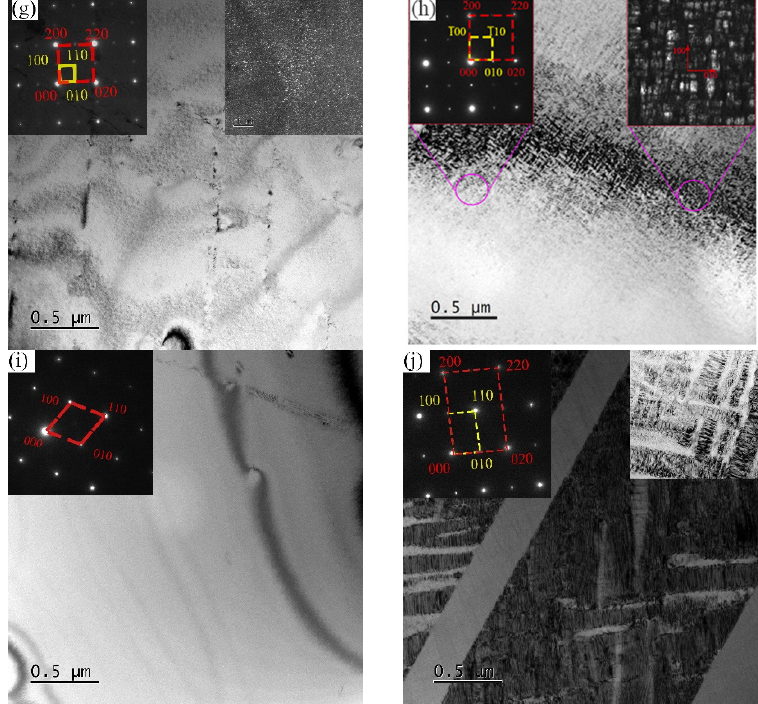
Figure 2. TEM morphology and diffraction patterns of experimental steels: ( a ) 7% Al under water- quenched, ( b ) 7% Al under furnace-cooled, ( c ) 8% Al under water-quenched, ( d ) 8% Al under furnace-cooled, ( e ) 9% Al under water-quenched, ( f ) 9% Al under furnace-cooled, ( g ) 10% Al under water-quenched, ( h ) 10% Al under furnace-cooled, ( i ) 11% Al under water-quenched, ( j ) 11% Al under furnace-cooled conditions.